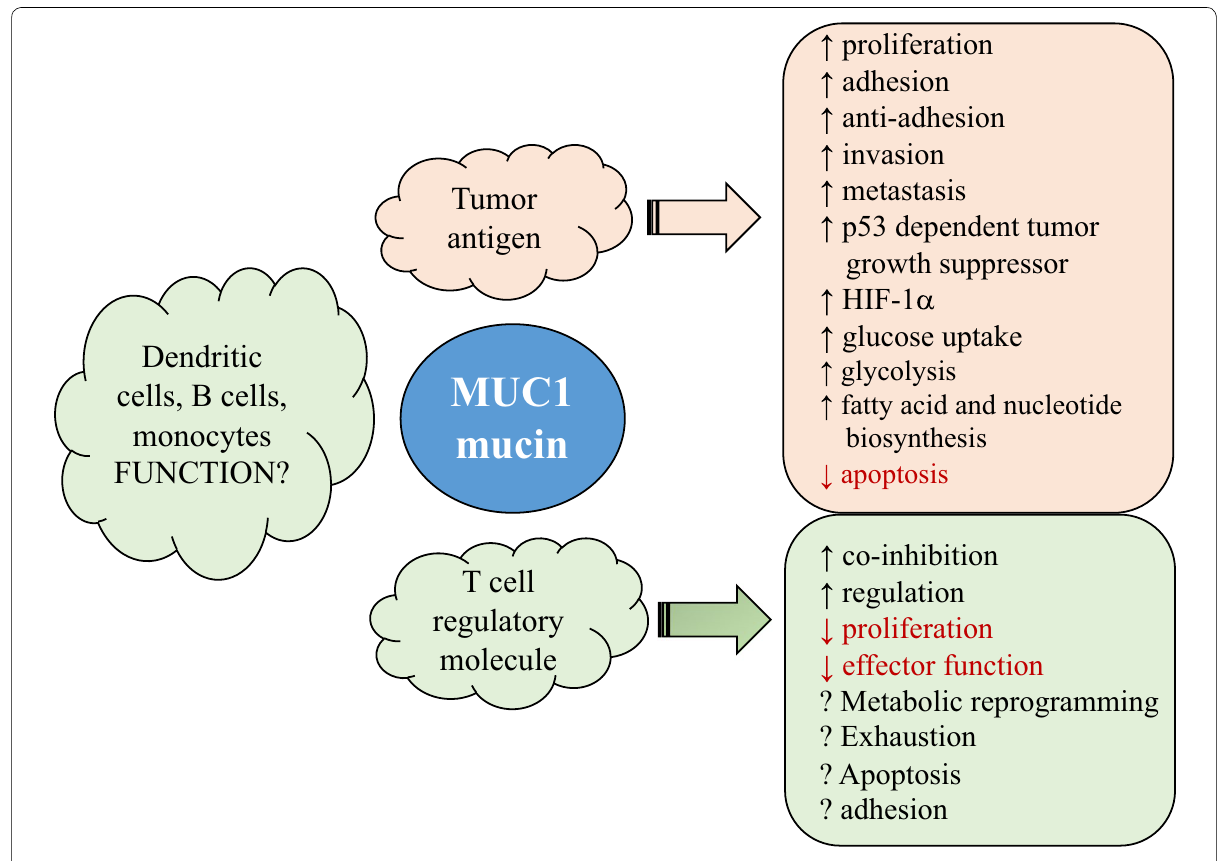
Fig. 3 MUC1 mucin: a molecule with complex functions. MUC1 mucin can be characterized as a pan-tumor antigen, associated with adenocarcinomas, lymphomas and leukemias, where it plays a significant role in proliferation, metabolism and metastasis of tumor cells. In addition, MUC1 is also expressed on immune cells such as T cells, B cells, dendritic cells and monocytes. On T cells, MUC1 is putatively a checkpoint molecule and serves as a co-inhibitory molecule. The function of MUC1 on other immune cells is not clear yet. MUC1 mucin exemplifies the level of complexity present within the TME and consequently the development of cancer